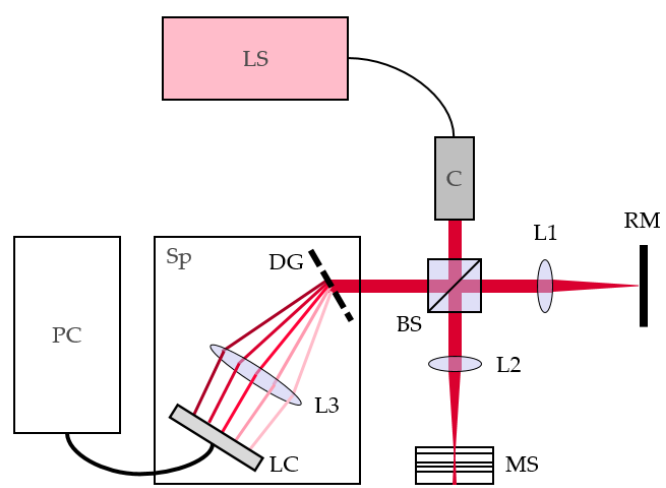
Figure 1. OCT principle and components: light source (LS); collimator (C); beam splitter (BS); focusing lenses (L1, L2); spectrometer lens system (L3); reference mirror (RM); multilayer sample (MS); spectrometer (Sp); diffraction grating (DG); line camera (LC); computer (PC).